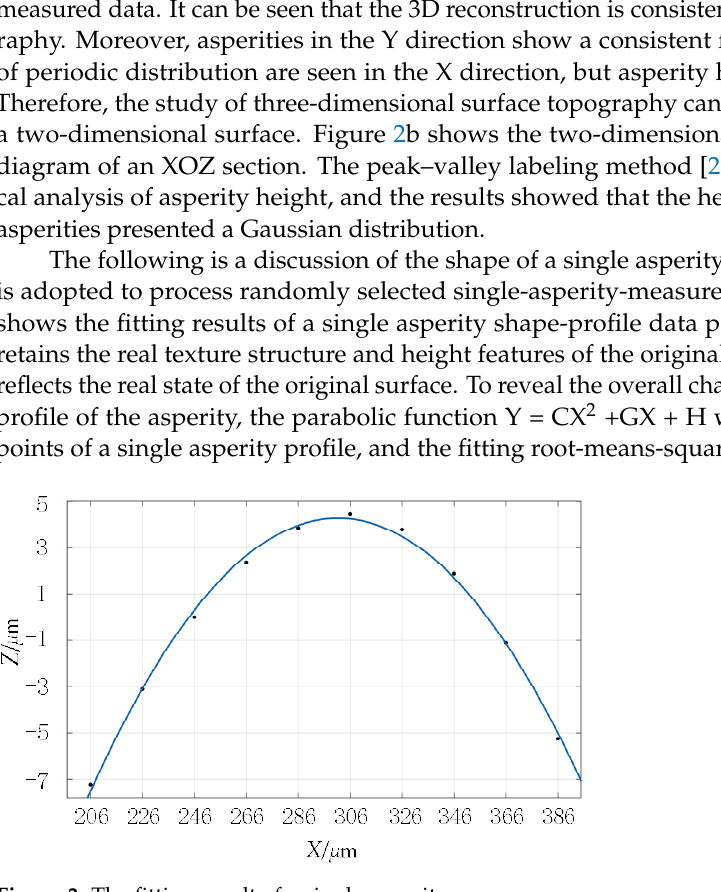
Figure 2. Reconstructed topographies in boring machining method: ( a ) 3D reconstructed topogra- phy; ( b ) 2D reconstructed topography.